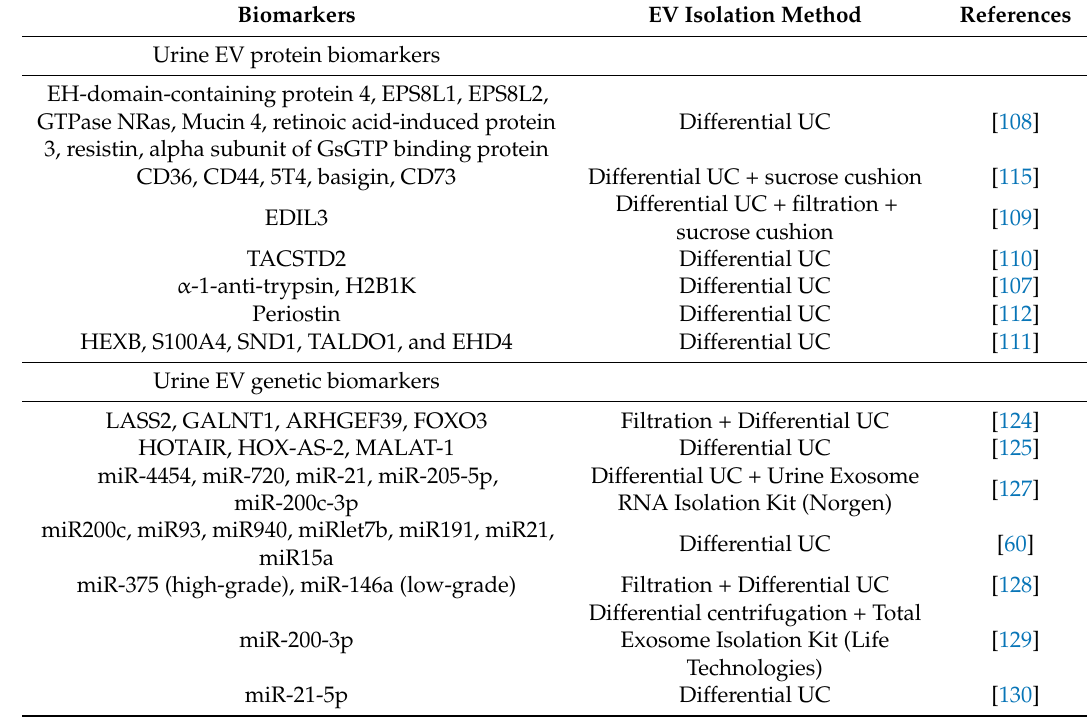
Table 3. Non-exhaustive overview of urinary EV biomarkers for bladder cancer. The EV isolation method used in the study is also